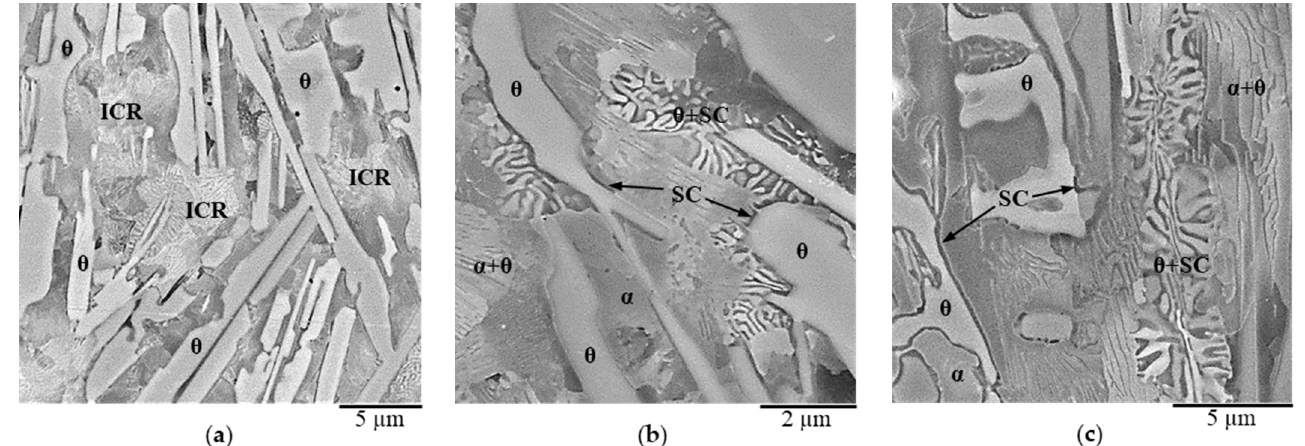
Figure 1. Cross-sectional SEM images (BSE contrast) of white-solidified ( a , b ) commercially available cast iron T-2.5Si-0.2Mn-0.1Cu, and ( c ) M-3.5C-3Si model alloy after EBR ( θ —eutectic cementite, α —ferrite, α + θ —pearlite, SC—silicocarbide, ICR—intercarbidic regions, which include the microstructural components α , α + θ and SC). Both images are from nitrided specimens in a depth unaffected by the inward-diffusing N.